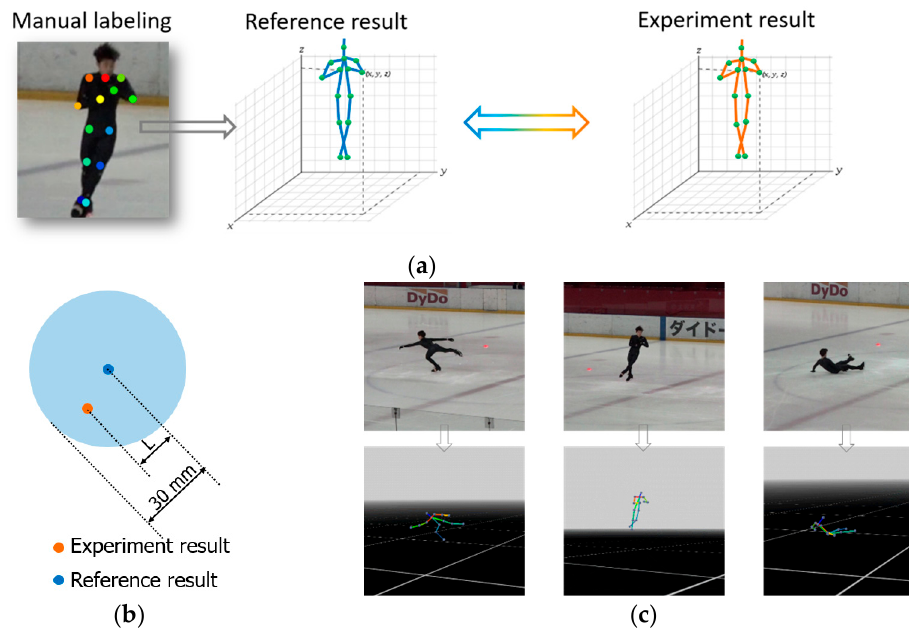
Figure 7. The quality grade of results is determined by comparing them with the reference spatial points which are reconstructed from the manually labeled 2D pixel values. ( a ) Evaluation method; ( b ) the allowable range of error; ( c ) experimental result. The quality grade of results is defined